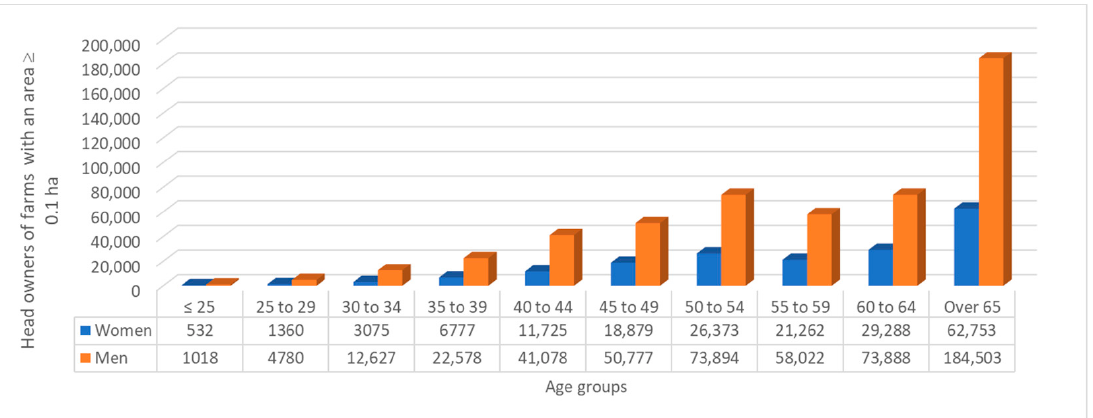
Figure 8. Distribution of head owners of farms with an area greater than or equal to 0.1 ha, according to age groups and sex in Spain (2016) [63].